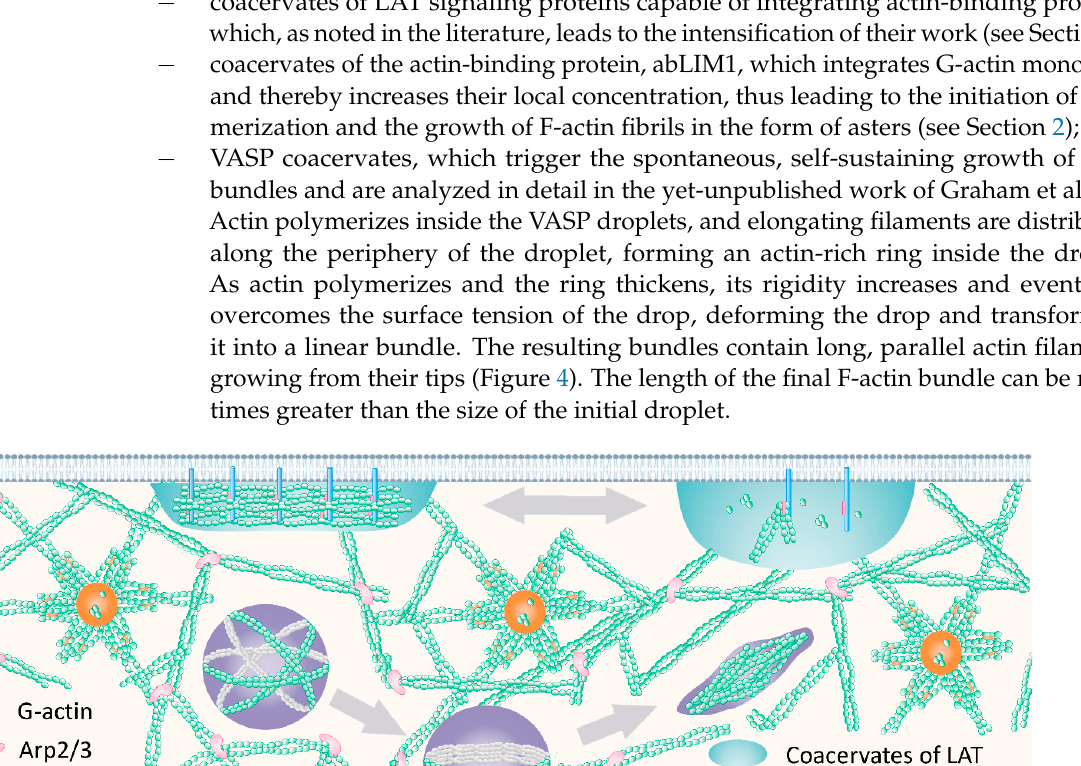
10 of 13 polymerized structures of F-actin began to appear in the condensed PSD assemblies 15 min after the onset of the phase transition. Actin bundles colocalized with PSD conden- sates gradually became thicker and longer. Phalloidin staining confirmed that the bundles were actin filaments. Without the addition of the five PSD components but with the pres- ence of cortactin, the Arp2/3 complex, and G-actin, actin bundles were not observed. Fi- nally, it has been shown that PSD can also promote the formation of actin bundles on lipid bilayers in the absence of Arp2/3. Thus, it has been shown that PSD condensates can pro- mote F-actin assembly by increasing the concentration of G-actin and cortactin. 5. Conclusions To date, it is becoming more and more obvious that the LLPS of proteins is of a uni- versal nature and, apparently, mediates all known cellular processes [9]. The process of the formation of F-actin, which is one of the main components of the cytoskeleton, is no exception. Figure 4 shows the coacervates that are known, to date, to arise from LLPS, which